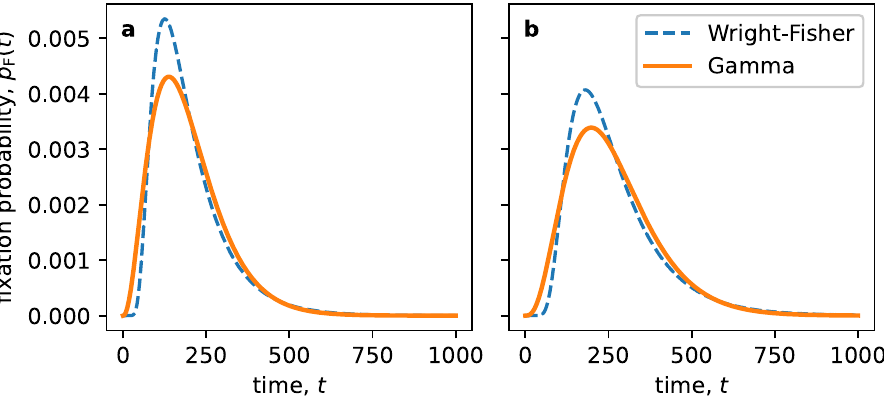
Fig 3. Approximation of the fixation time distribution obtained numerically for the Wright-Fisher model (dashed line) with a Gamma distribution given by Eq 2. In (a) the Wright-Fisher model has N = 100 individuals and no selection. In (b) N = 150 and s =